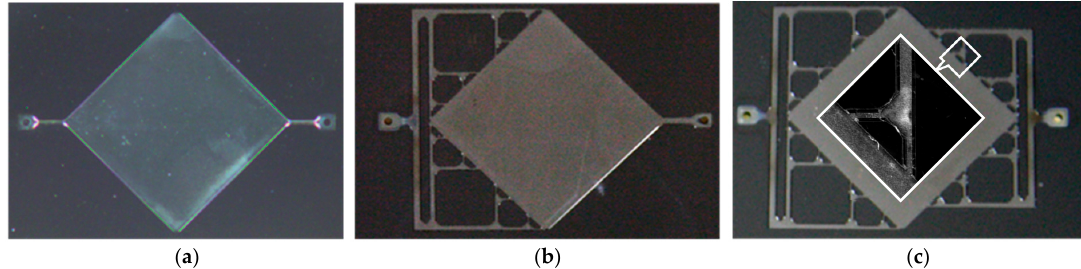
Figure 9. Optical microscope image of the microfluidic circuits after micromachining. Structure ( a ) C4 single input and output; ( b ) C5 single or distributed input and output; ( c ) C6 distributed input and output (central inset showing a zoomed view of the intersection between channels and with the chamber).